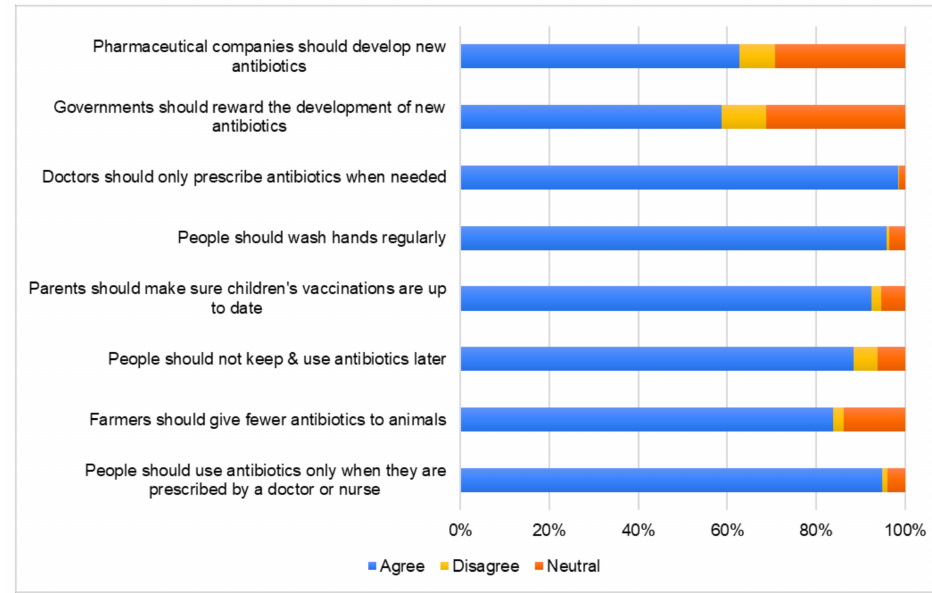
Figure 2. Perceptions of respondents towards antibiotic use and antibiotic resistance.